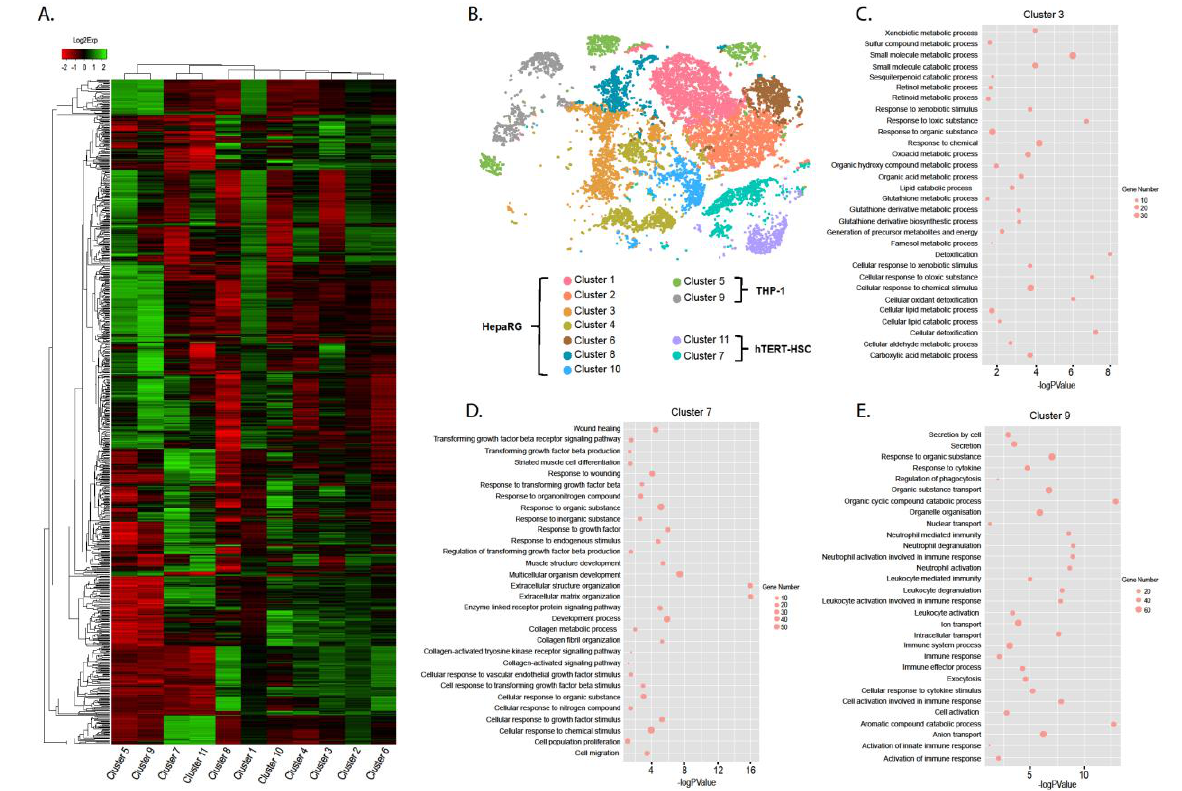
Figure 4. Graph-based clustering of untreated MTs to identify cell sub-groups. Single cell sequencing data was evaluated using Graph-based unsupervised clustering. Cells could be grouped in 11 clusters represented in a heatmap depicting differentially expressed genes for each cluster ( A ). Clusters 1 to11 are shown in a tSNE plot with the clusters grouped into the corresponding cell type ( B ). The identified differentially expressed genes for each cluster were analyzed regarding biological processes using Gene Ontology (GO; http://geneontology.org/, accessed on 20 January 2021). Examples of the biological pathways from three clusters are depicted: Cluster 3 is an example of HepaRG ( C ); Cluster 7 is an example of hTERT-HSC ( D ); Cluster 9 is an example of THP-1 ( E